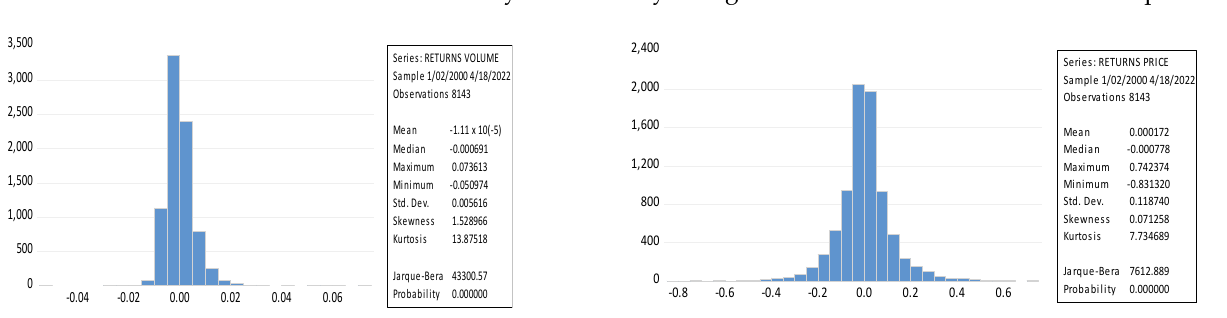
Figure 1. Observed distribution of daily volume and prices returns in the Colombian electricity market (1 January 2000 to 14 February 2022).